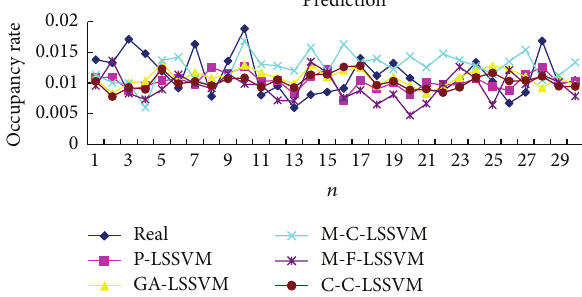
Figure 9: Five models predicted diagram for interphone band.